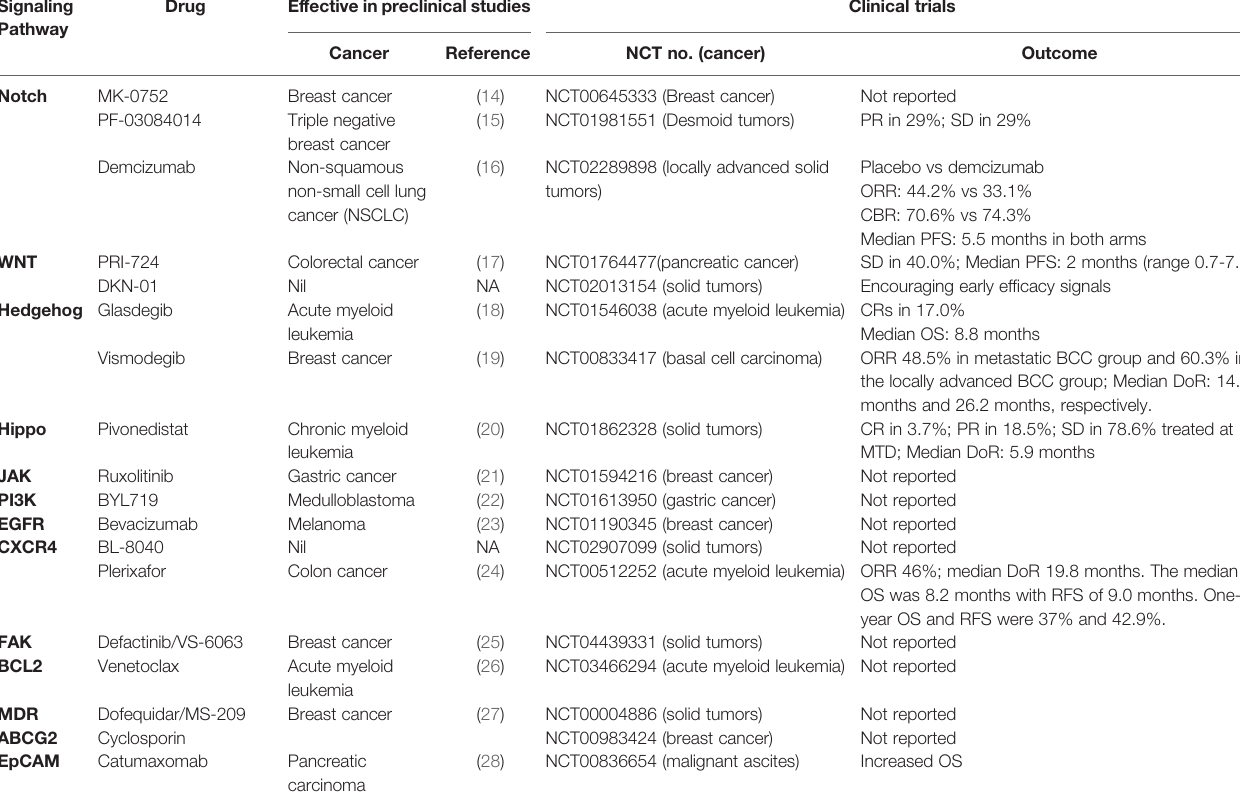
TABLE 1 | The drugs targeting CSCs in clinical